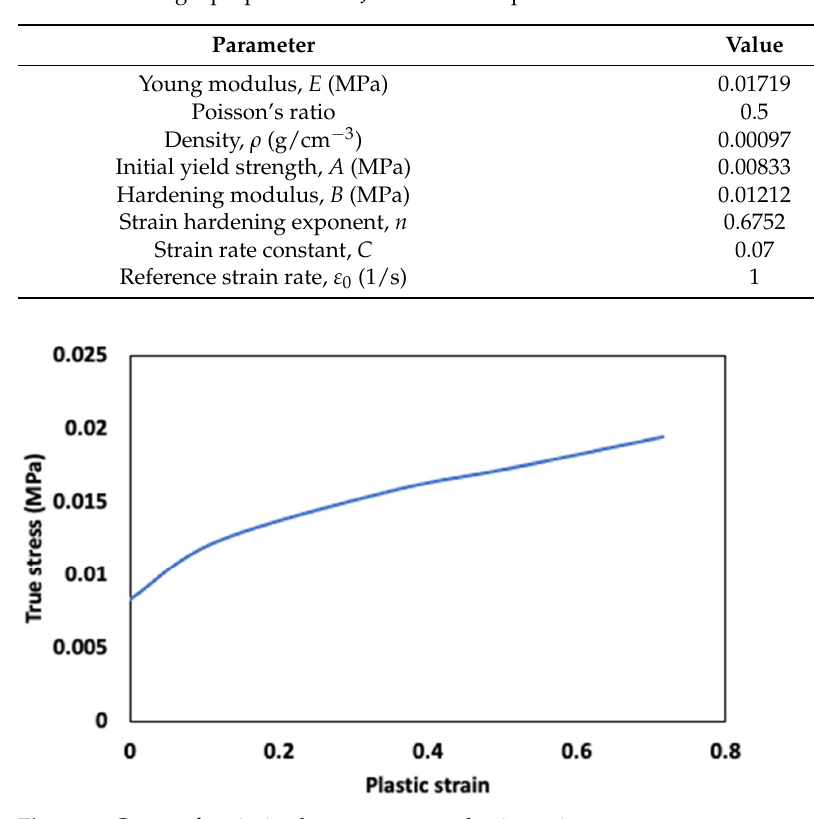
Figure 6. Curve of surimi gel true stress vs. plastic